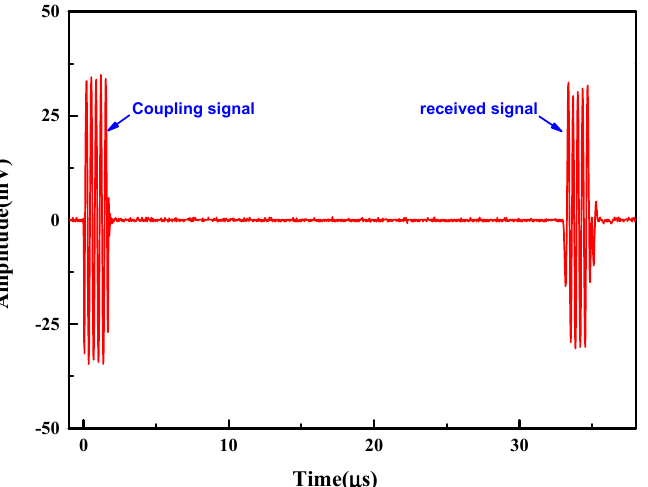
Figure 12. Response waveforms of the hydrophone when the CMUT was driven by the excitation waveform and DC bias voltages.